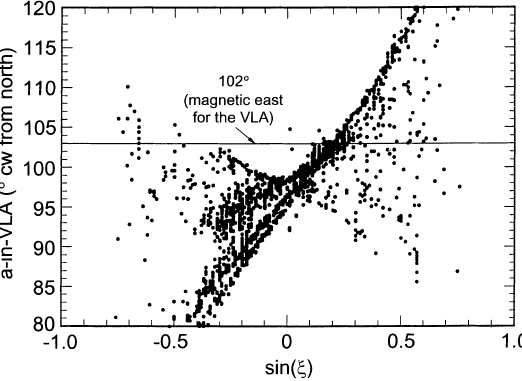
Fig. 4. Relationship between sin (cid:133) (cid:110) (cid:134) (see Fig. 5) and ^ a -projected-onto- VLA-plane. For every event in the JE93 event pool, we project the ^ a - direction at L (cid:136) 2 : 2 along the line of sight (see text for the reason behind this number) onto the plane of the VLA. As the line of sight moves westward, ^ a -projected moves clockwise; it is equal to 102 (cid:14) for only a limited range of look directions just north of the meridian